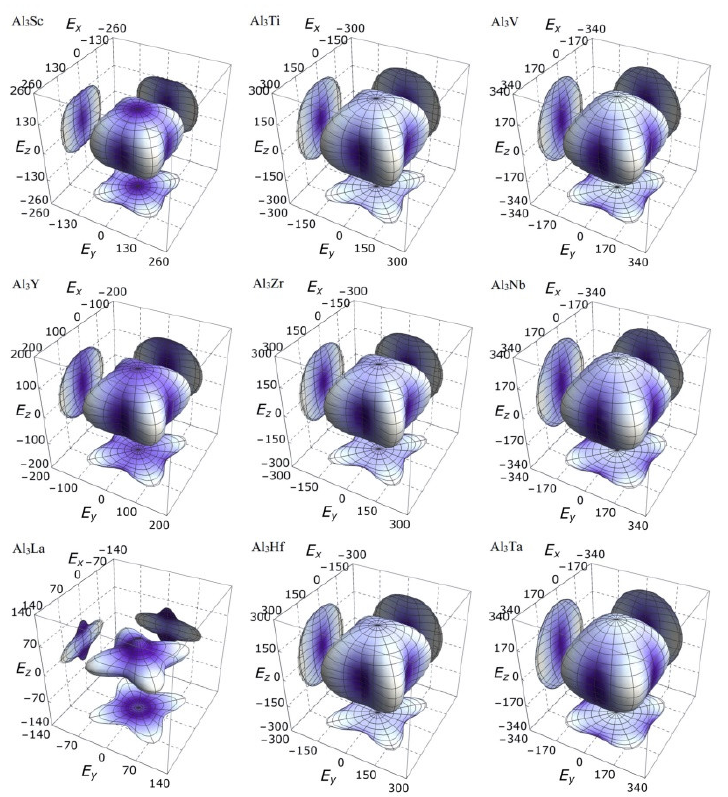
Figure 7. The anisotropic characteristics of Young’s modulus of the Al 3 TM compounds.